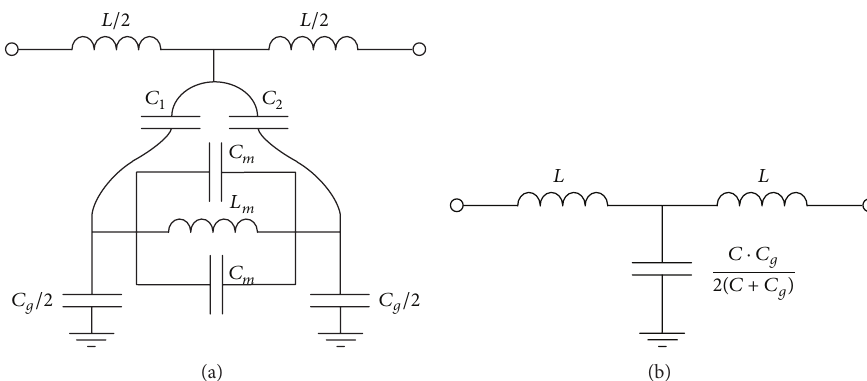
Figure 9: (a) Lumped element-equivalent circuit model of a microstrip line loaded with an MLC whose electric wall is aligned with or laterally displaced with regard to the line; (b) circuit model after applying the magnetic wall concept under the assumption of alignment, that is, 𝐶 1 = 𝐶 2 = 𝐶/2 .